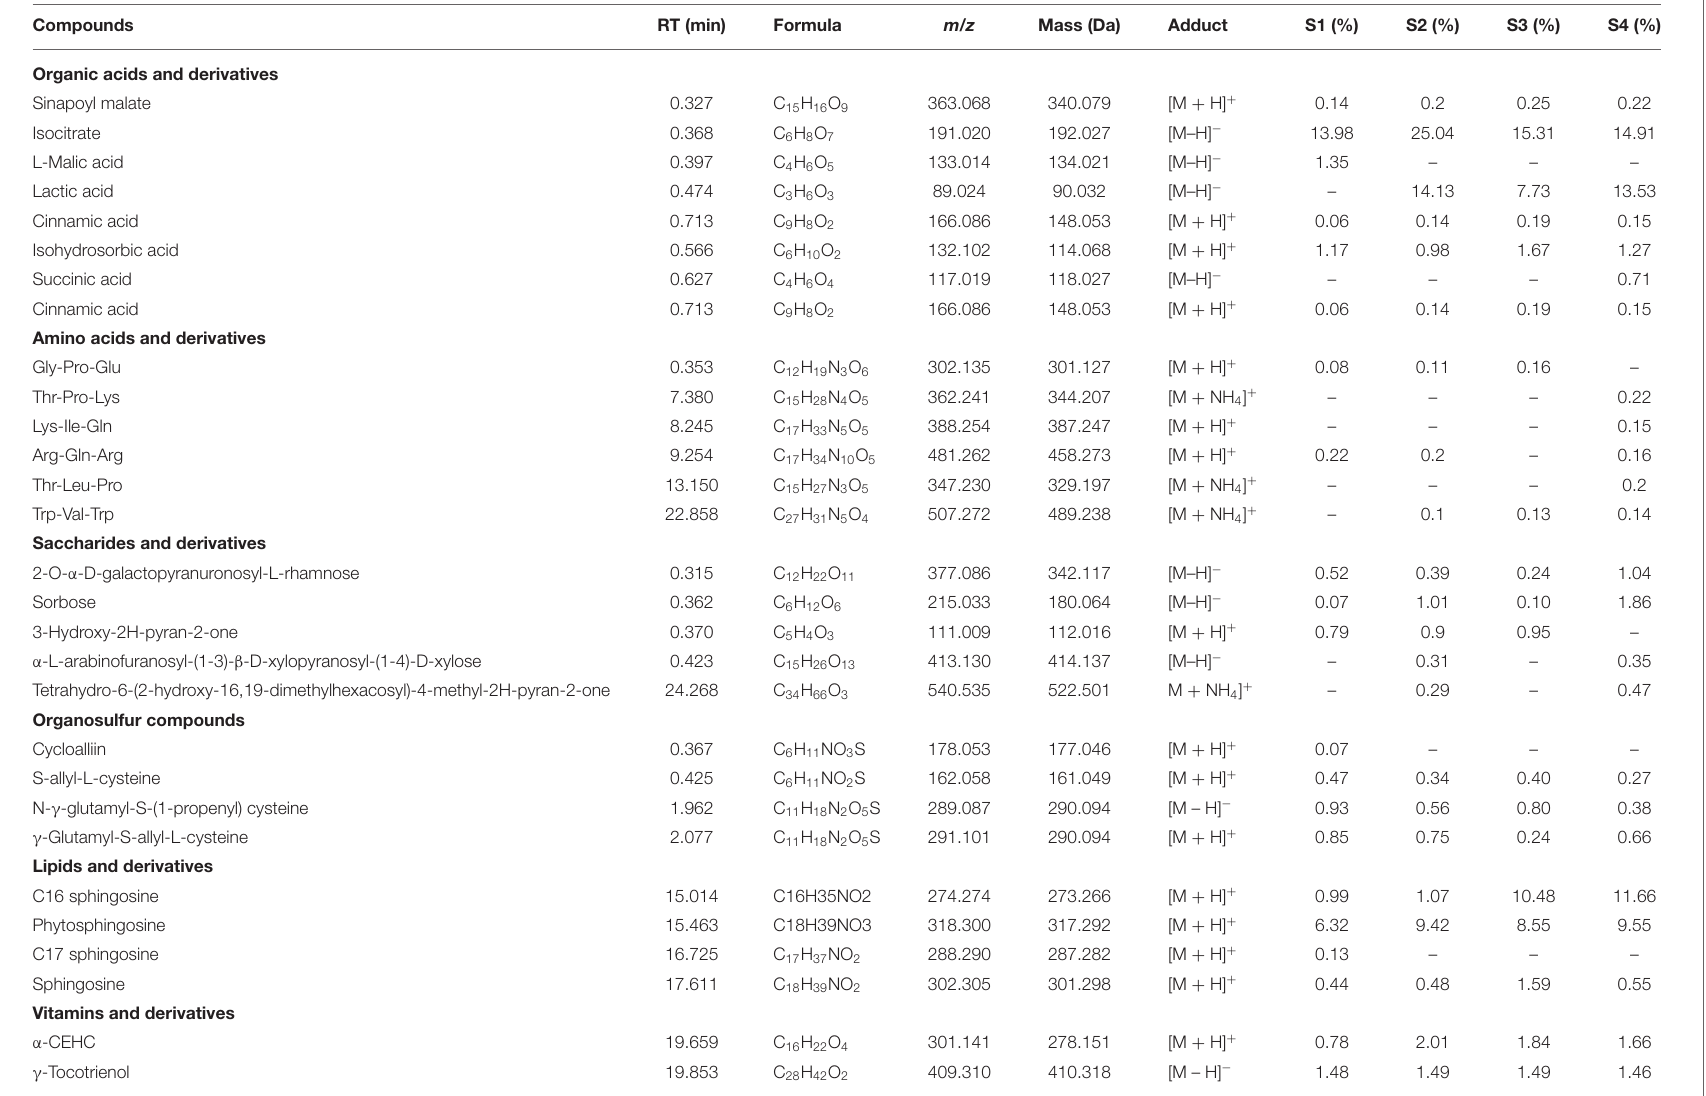
TABLE 3 | Main substances identified in black garlic broth by